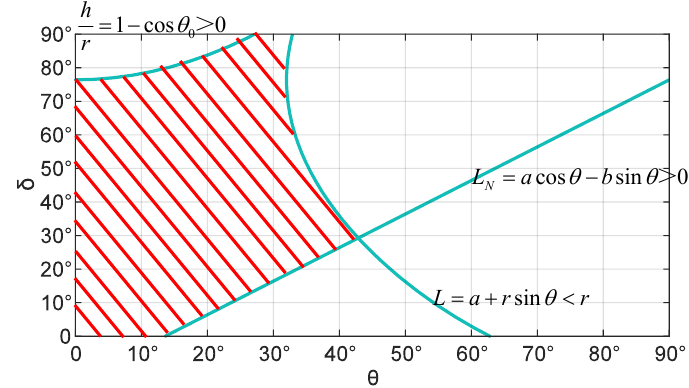
Figure 7. Value range of θ and δ.